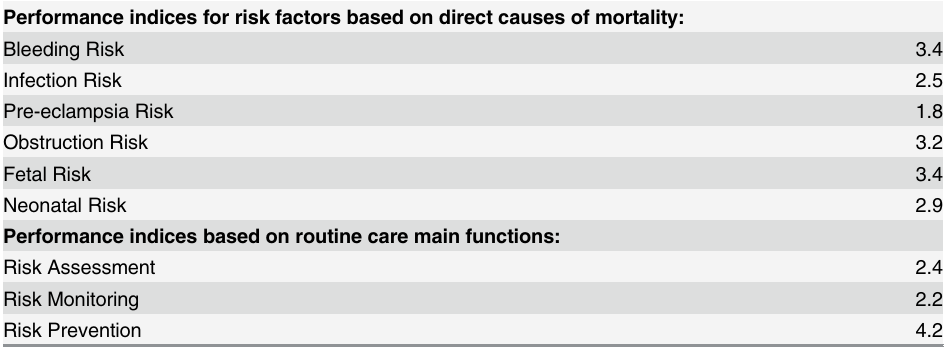
Table3. Overallperformance indices (usingrelative scalerangingfrom 0= no performance to 5 = com- plete performance). Performance indices for risk factors based on direct causes of mortality: Bleeding